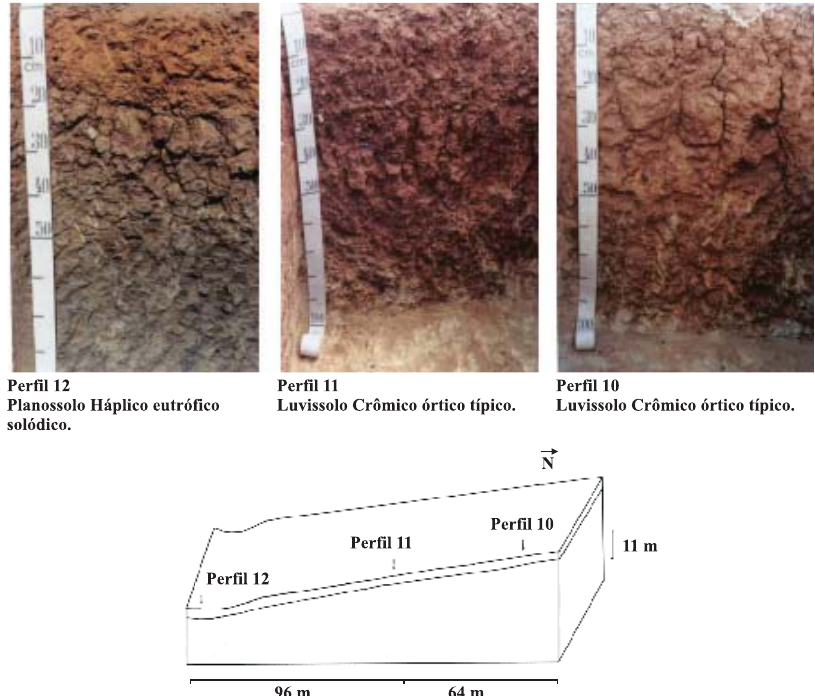
Figura 4. Representação esquemática da localização dos perfis ao longo da sequência e fotografias dos perfis de solo da topossequência